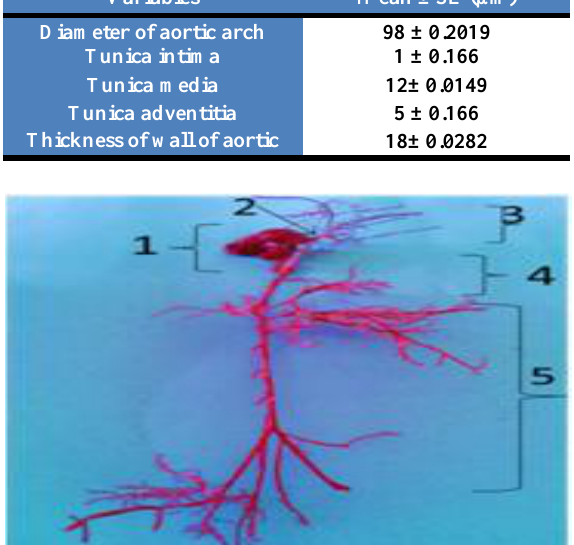
Figure, 1: The cast of the aortic arch in local breed rabbits showing: 1.heart, 2. Ascending aorta, 3. Aortic arch, 4.Descending thoracic aorta, 5.Abdominal aorta.